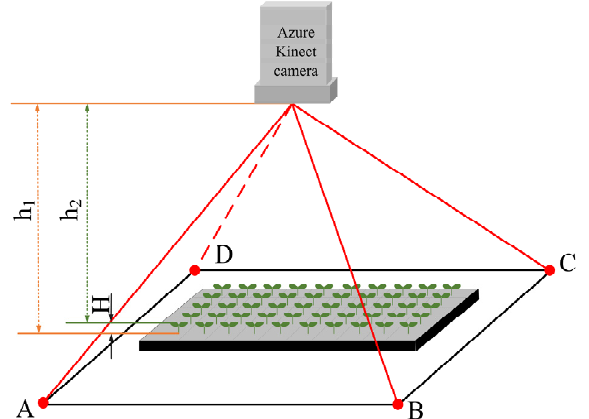
Figure 6. Plant height detection schematic.